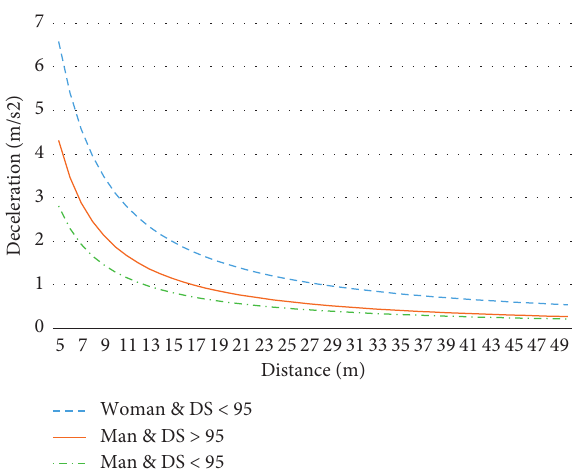
Figure 7: Relationship between deceleration and distance in dif- ferent groups of